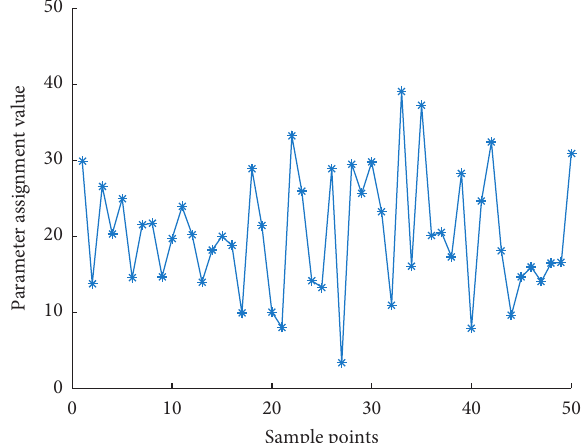
Figure 4: Line chart of hardware parameter allocation of the VR